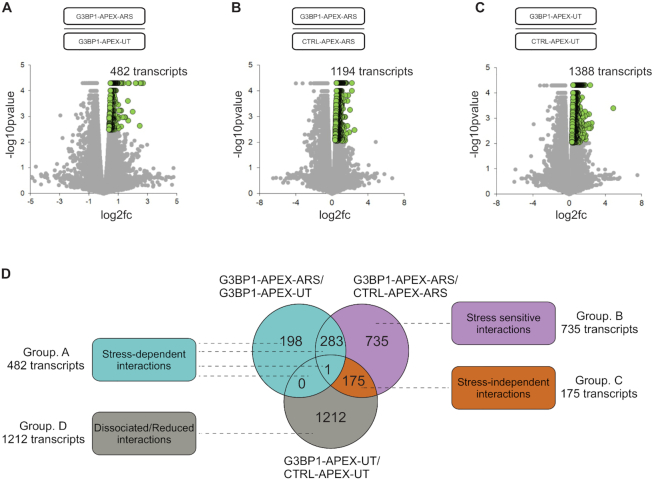
RNAseq of G3BP1 associated transcripts. Volcano plot showing G3BP1 associated transcripts with comparisons: (A) G3BP1-APEX-ARS/G3BP1-APEX-UT; (B) G3BP1-APEX-ARS/CTRL-APEX-ARS and (C) G3BP1-APEX-UT/CTRL-APEX-UT (see text for more details). (D) Venn diagram showing a comparison of G3BP1-associated transcripts in unstressed and arsenite stressed, dividing the transcripts into four groups, namely stress-dependent (green shaded), stress-sensitive (purple shaded), stress-independent (light-brown shaded), and transcripts with reduced or dissociated interactions (grey shaded) after arsenite stress.